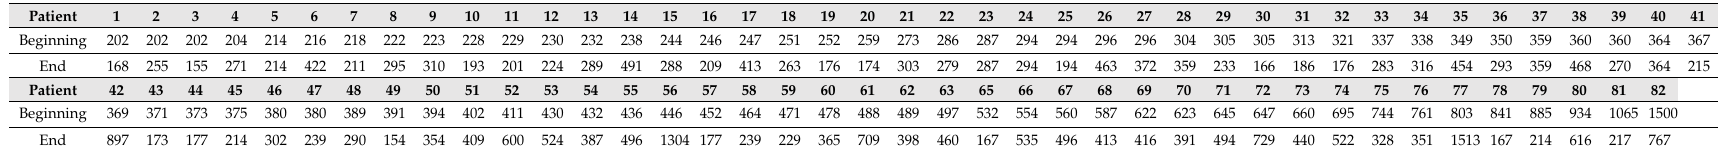
Table 5. Serum cobalamin levels (pg/mL) during maintenance therapy; at the beginning of follow-up and at the end of